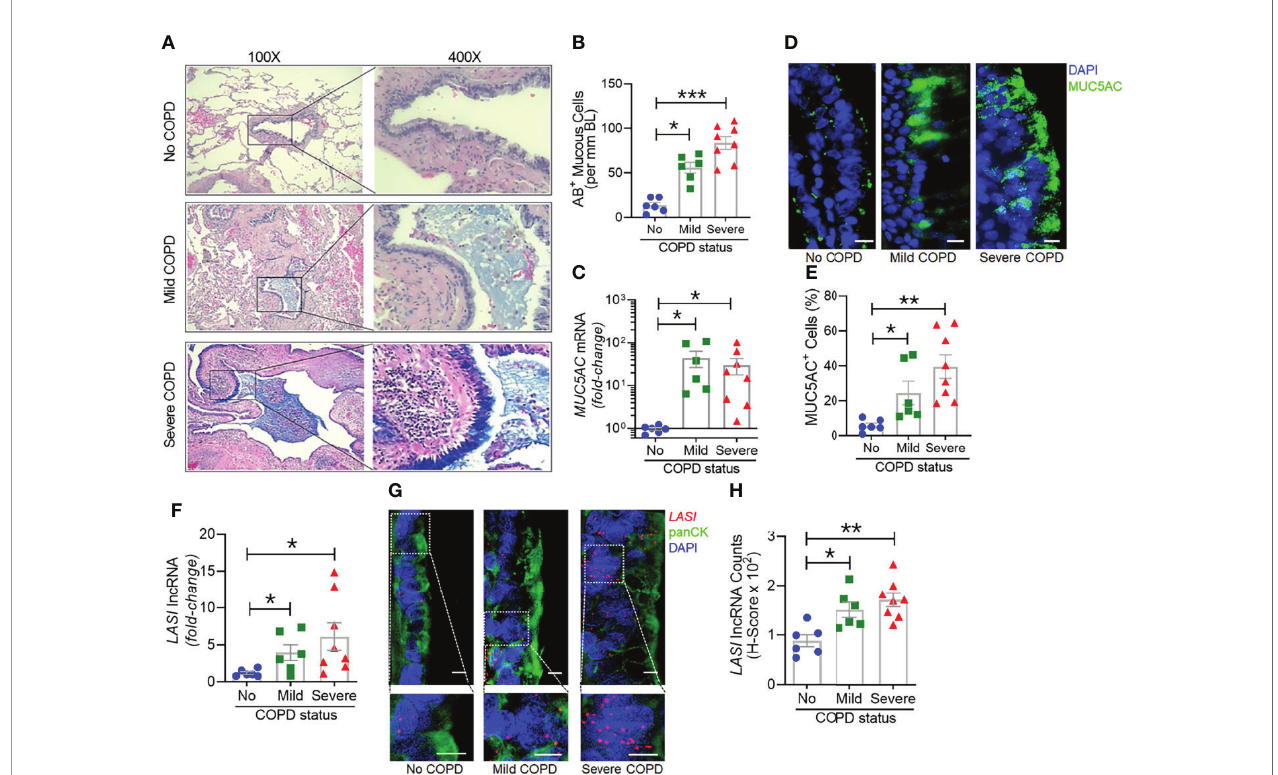
FIGURE 2 | Archived airway sections of COPD patients show increased mucus expression and goblet cell hyperplasia along with increased LASI lncRNA expression in epithelial cells. (A) Representative histomicrographs of airway tissue sections from subjects with No, Mild, or Severe COPD stained with alcian blue (AB). Images are shown at 100x magni fi cation and inset images are magni fi ed 400x in the right panels. (B) Quanti fi cation of AB+ mucous/goblet cells per mm of basal lamina (BL). (C) Relative quantities of MUC5AC mRNA levels in tissues from mild and severe COPD subjects compared to control subjects with no COPD, analyzed by qRT-PCR. (D) Micrographs showing MUC5AC mucin immunopositivity (green) in tissue sections and counterstained with DAPI (shown in blue) to identify nuclei, scale – 10 µm. (E) Quanti fi cation of MUC5AC+ cells per mm BL in each group. (F) Quantitation of LASI lncRNA levels in mild and severe COPD subjects compared to control subjects with No COPD. (G) Micrographs showing LASI lncRNA levels in airway epithelial cells of patient bronchial tissues. LASI lncRNAs were detected by RNA-FISH (shown in red) and epithelial cells were immunostained by pan-cytokeratin (panCK, shown in green) antibody, and nuclei (shown in blue) were stained by DAPI. Lower panels show magni fi ed images of the insets drawn in upper panels (scale – 5µm). (H) Quantitation for LASI lncRNAs per epithelial cell as measured by H-score analysis. Data shown as mean ± SEM; n=6-8/gp; data analyzed by ANOVA with multiple comparisons; * p <0.05; ** p <0.01; *** p